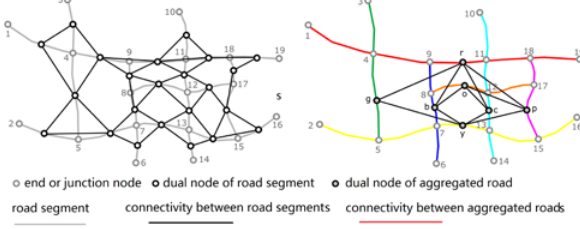
Figure 1. An exemplary road network a) in road segment form with corresponding topological representation, b) in natural road form with its topological representation (Jiang et al.